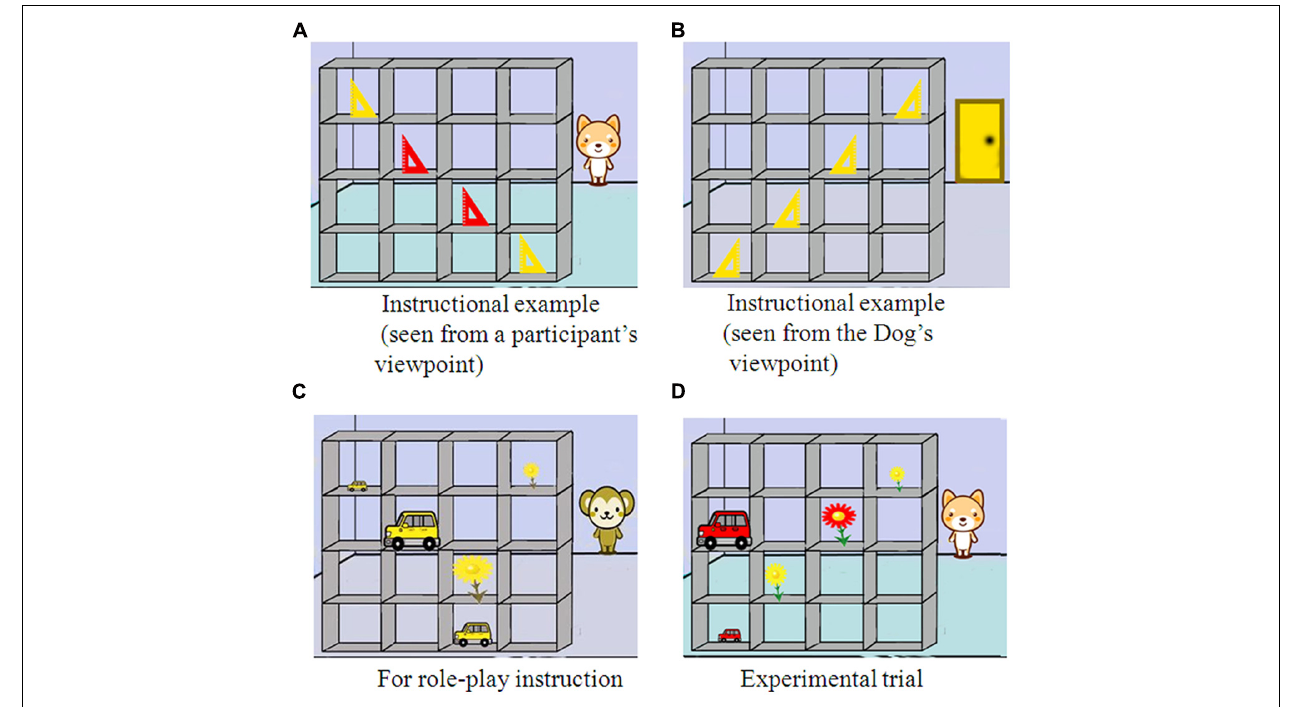
FIGURE 2 | Examples of stimuli used in the study. (A) shows instructional example (seen from a participant’s viewpoint). (B) shows instructional example (seen from the Dog’s viewpoint). (C) shows an example stimulus for role-play instruction. (D) shows an example stimulus for experimental trial.